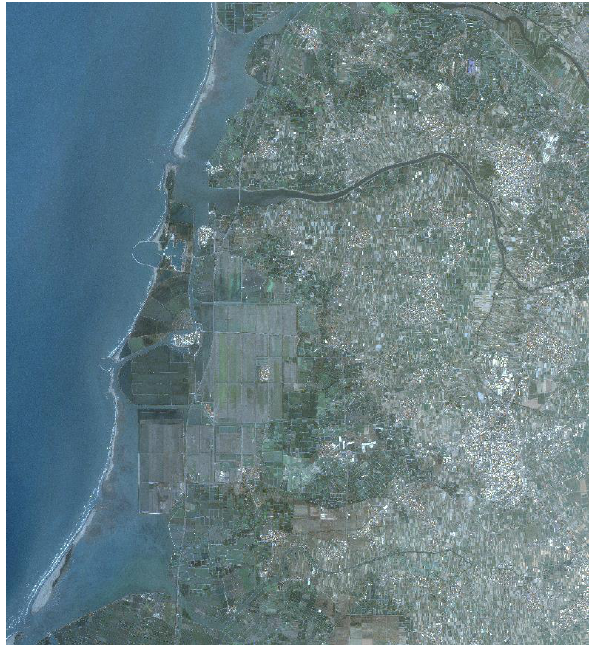
Figure 7. Result of 2D projective transformation.